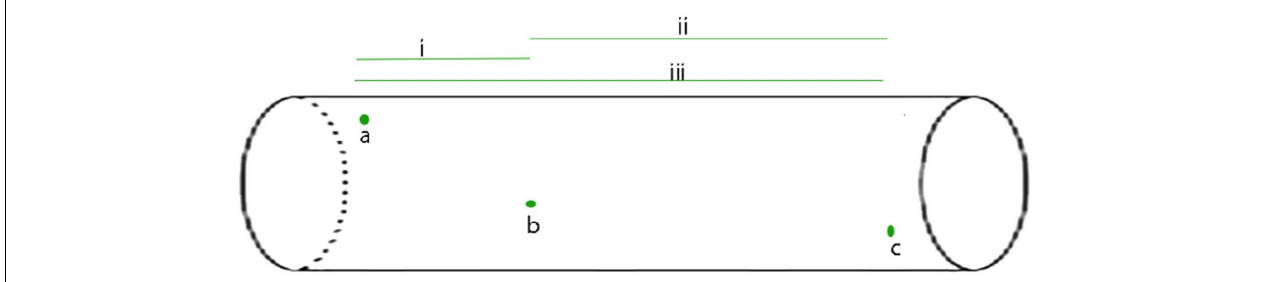
FIGURE 1 | The APPulse - an illustrative, uniform axon containing three widely spaced ion protein channels is shown. For the benefit of a clear description the axon has been standardized as follows: 1 the axon is uniform such that speed along the axon by the lipid pulse is constant; 2 - the protein channels (in green) are gates that reach threshold at a voltage of V and produce a digit of Entropy E; 3 - in this axon there are no lipid channels or other proteins except the three ion channel proteins, a, b, c. The diagram illustrates the events that take place for the APPulse to continue between ion channels. On depolarization at a, an action potential digit of entropy E is created. A Lipid pulse is subsequently created by Entropy E that continues along the axon. Entropy loss e from E causes a proportionate decrease in amplitude but the velocity of the soliton is constant where the membrane components are uniform. This causes the entropy to decrease by dissipation over distance d such that Ed(b) = E-e. This residual entropy Ed (b) is enough to mechanically distort the ion channel at b breaking the electrostatic insulation. Contraction of the ion channel ensues completing the mechanism. In this model the entropy of electrostatic forces produced by the ion channel at (a) must be sufficient to produce a lipid pulse of such entropy E to arrive at (b) with sufficient entropy to break the electrostatic insulation of (b) and repeat to c, where the process again repeats itself. In smaller diameter neurons dissipation will be greater due to entropy being a function of membrane area. i, ii, and iii represent different timings between separated